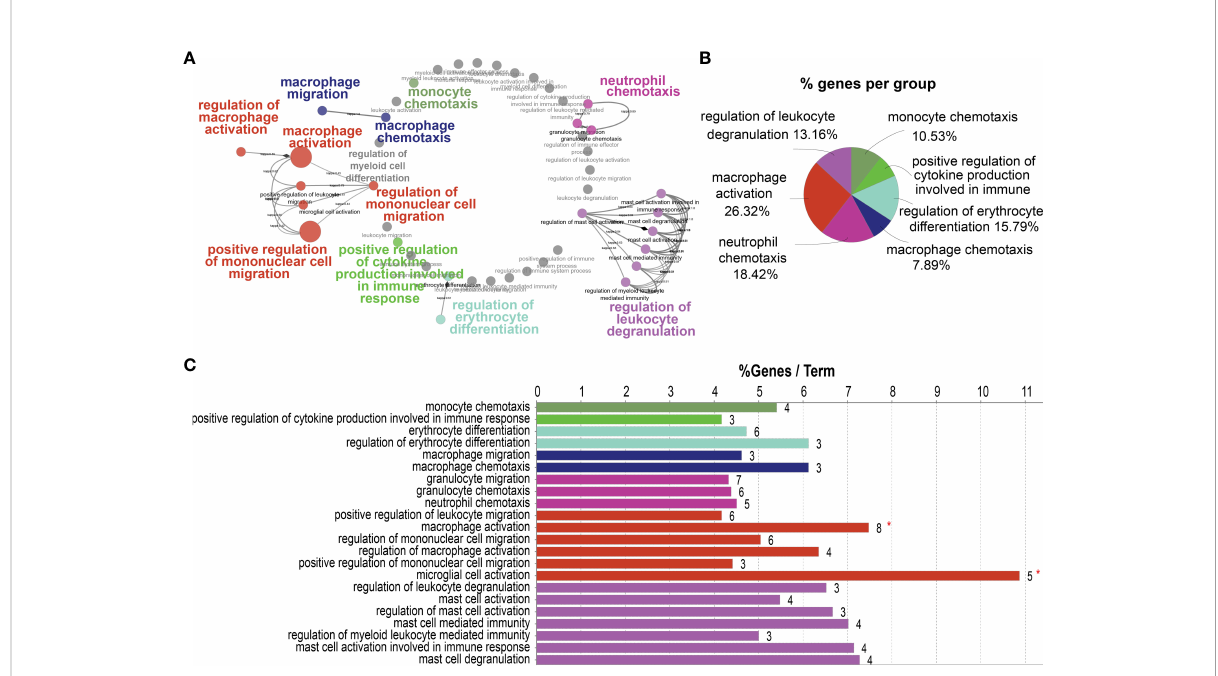
FIGURE 4 Potential pathways correlated with high HB-EGF-related genes using TCGA-LUAD: 182 genes exhibiting the highest correlation with HB-EGF were used for pathway analysis in ClueGO software. (A) Functionally grouped networks with terms as nodes linked based on their k score level ( ≥ 0.3). (B) An overview chart with functional groups, including speci fi c terms related to high HB-EGF expression. (C) The chart presents speci fi c terms in (B) . The bars represent the number of genes from the analyzed cluster found to be associated with the term, and the label displayed on the bars is the percentage of identi fi ed genes compared with all genes associated with the